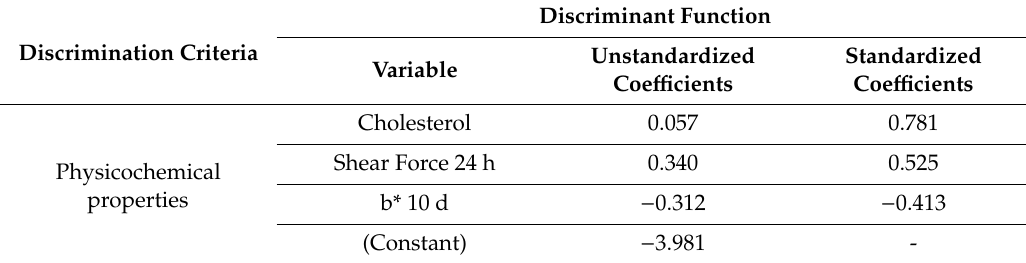
Table 3. Estimated coe ffi cients of the canonical discriminant function on the predictor variables, in discriminant analyses of genetic groups based on meat physicochemical properties, fatty acid profiles or